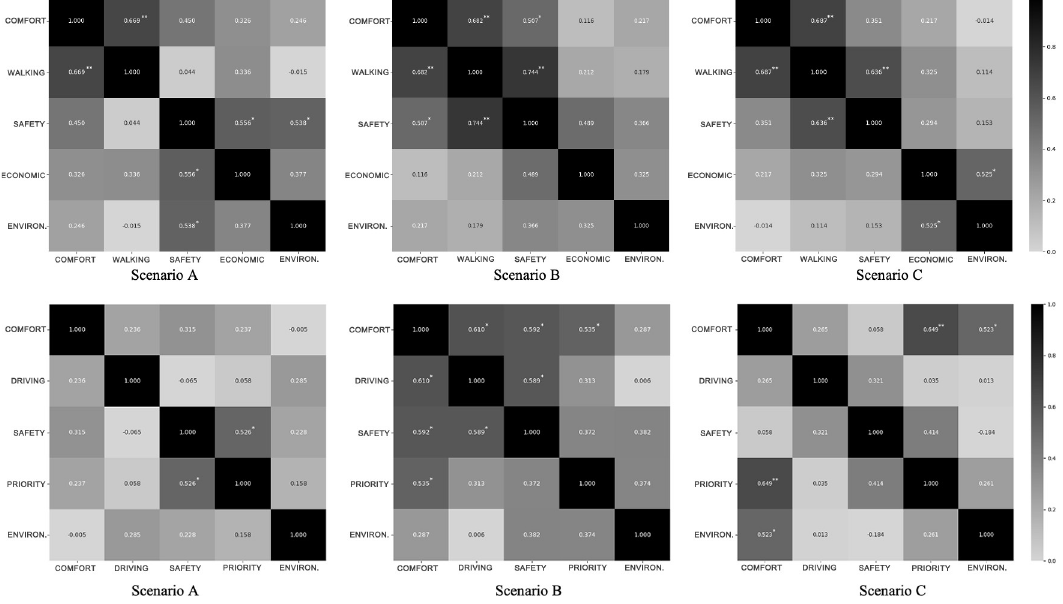
Fig 5. Spearman’s rank correlation matrix of pedestrian (a) and driver (b) experiment groups.